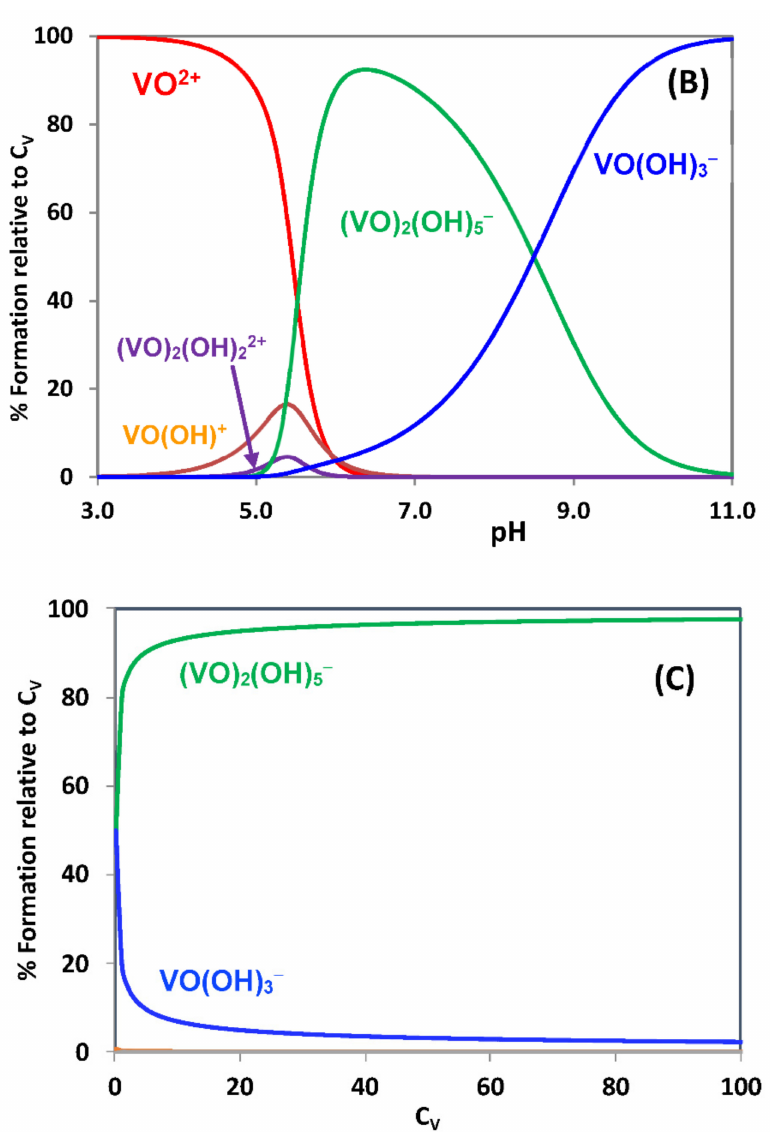
Figure 1. Species distribution diagrams, calculated with the computer program HySS [33], of V IV O 2+ hydrolysis: ( A ) at C V = 2 × 10 − 3 M, ( B ) at C V = 1 × 10 − 5 M, in the pH range 3–11; ( C ) at pH =